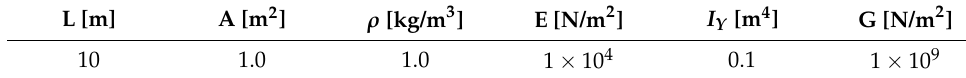
Table 2. Geometrical and material properties of the beam used for the vibration of a pinned rod.